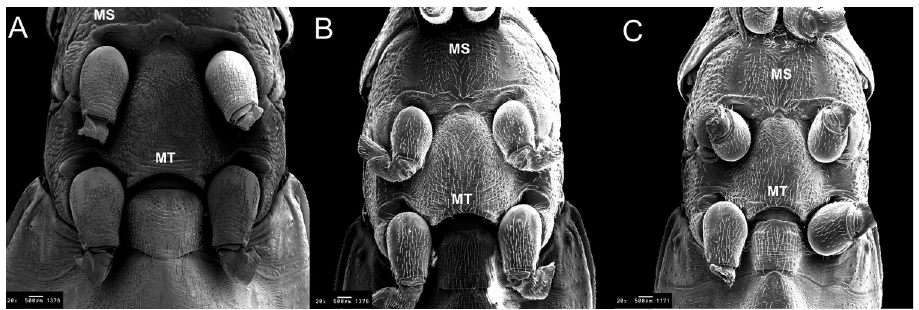
Figure 6. Thorax ventral of R. marabaensis sp. n. ( A ), R. prolixus ( B ), R. robustus ( C ). ms: mesosternum; mt: